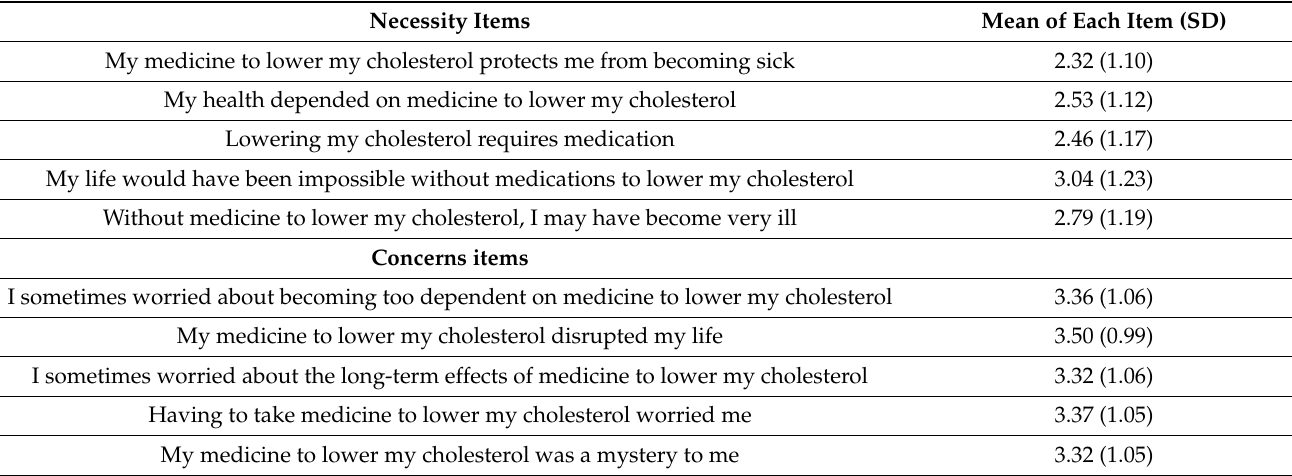
Table 2. Beliefs about medication questionnaire (BMQ) items.